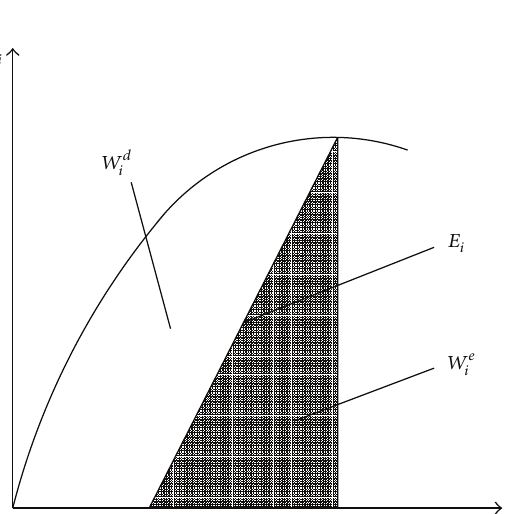
Figure 5: Impeller failure modes.